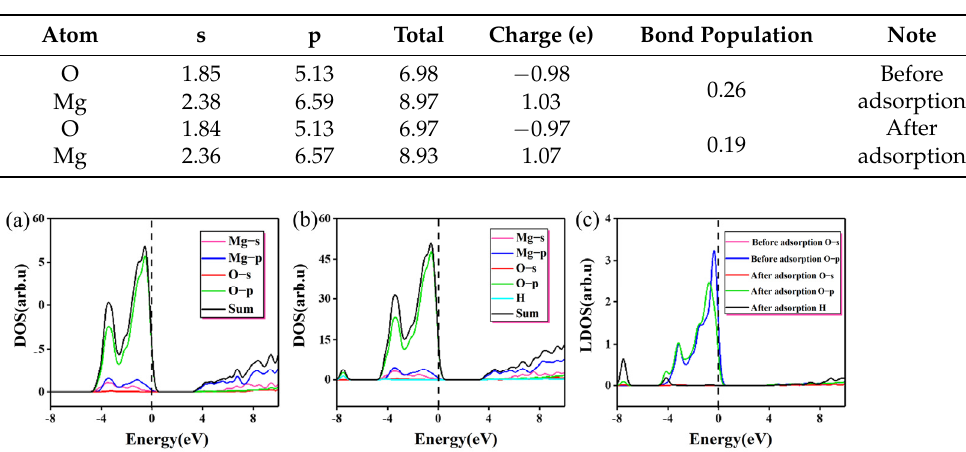
Table 3. Mulliken charge distribution near the adsorption site on MgO (100) plane.